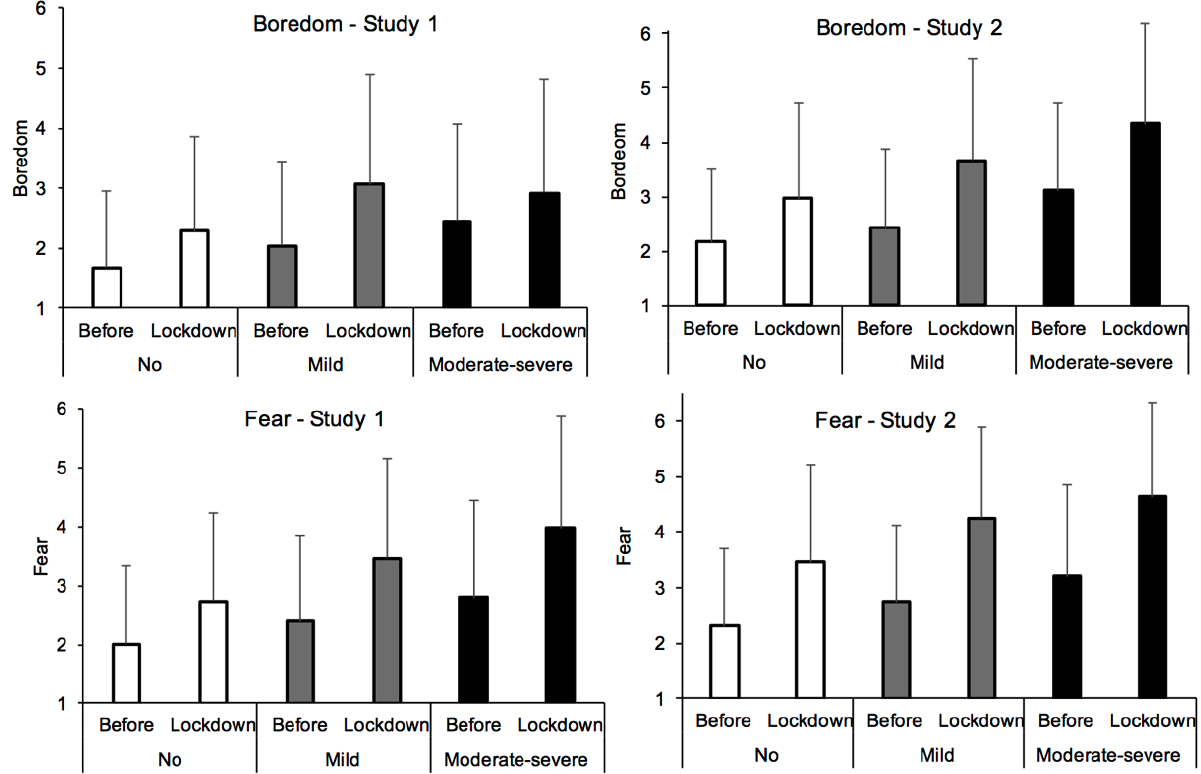
Figure 3 . Feelings of boredom and of fear as a function of severity of depressive symptoms in Study 1 and Study 2.